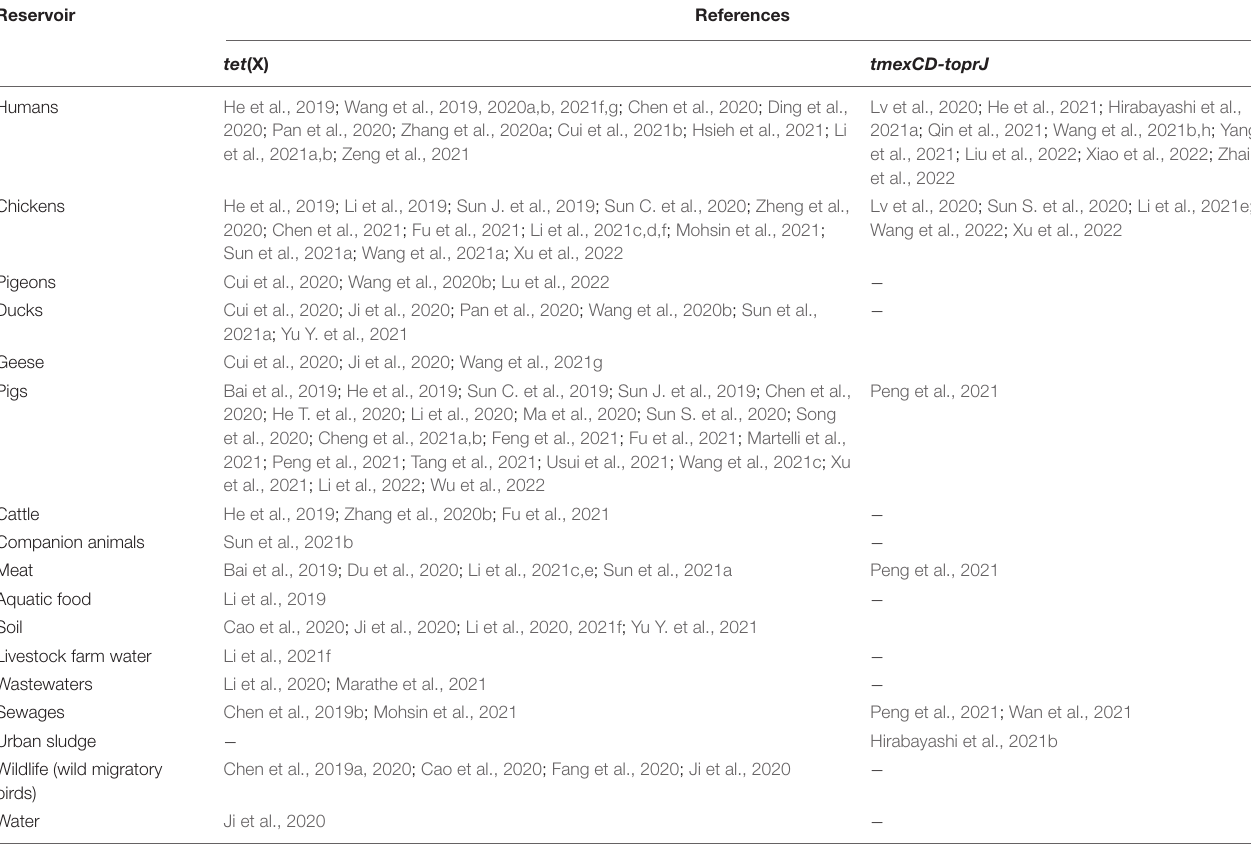
TABLE 2 | Specific reservoirs in which plasmid-borne transmissible tet (X) and tmexCD-toprJ genes have been detected.